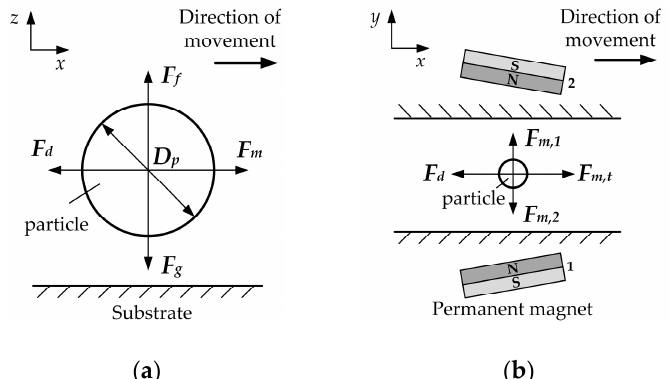
Figure 1. Schematic of the forces acting on the particle. ( a ) Forces analysis of a non-magnetic particle in the x, z- direction; ( b ) forces exerted on the particle when two permanent magnets are opposite in polarity.